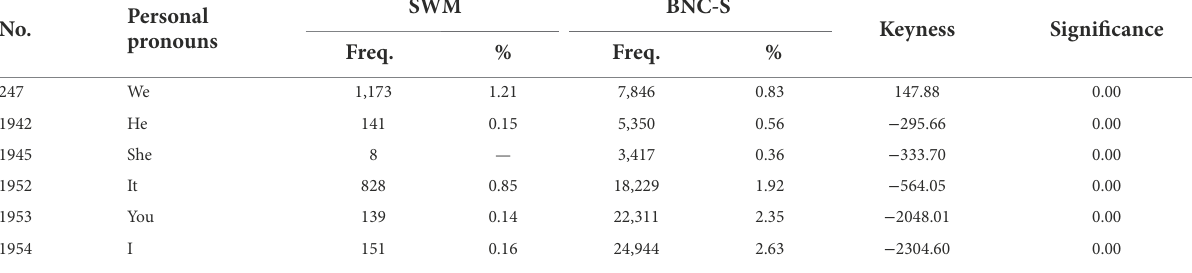
TABLE 7 Key personal pronouns in SWM (in comparison with BNC-S).